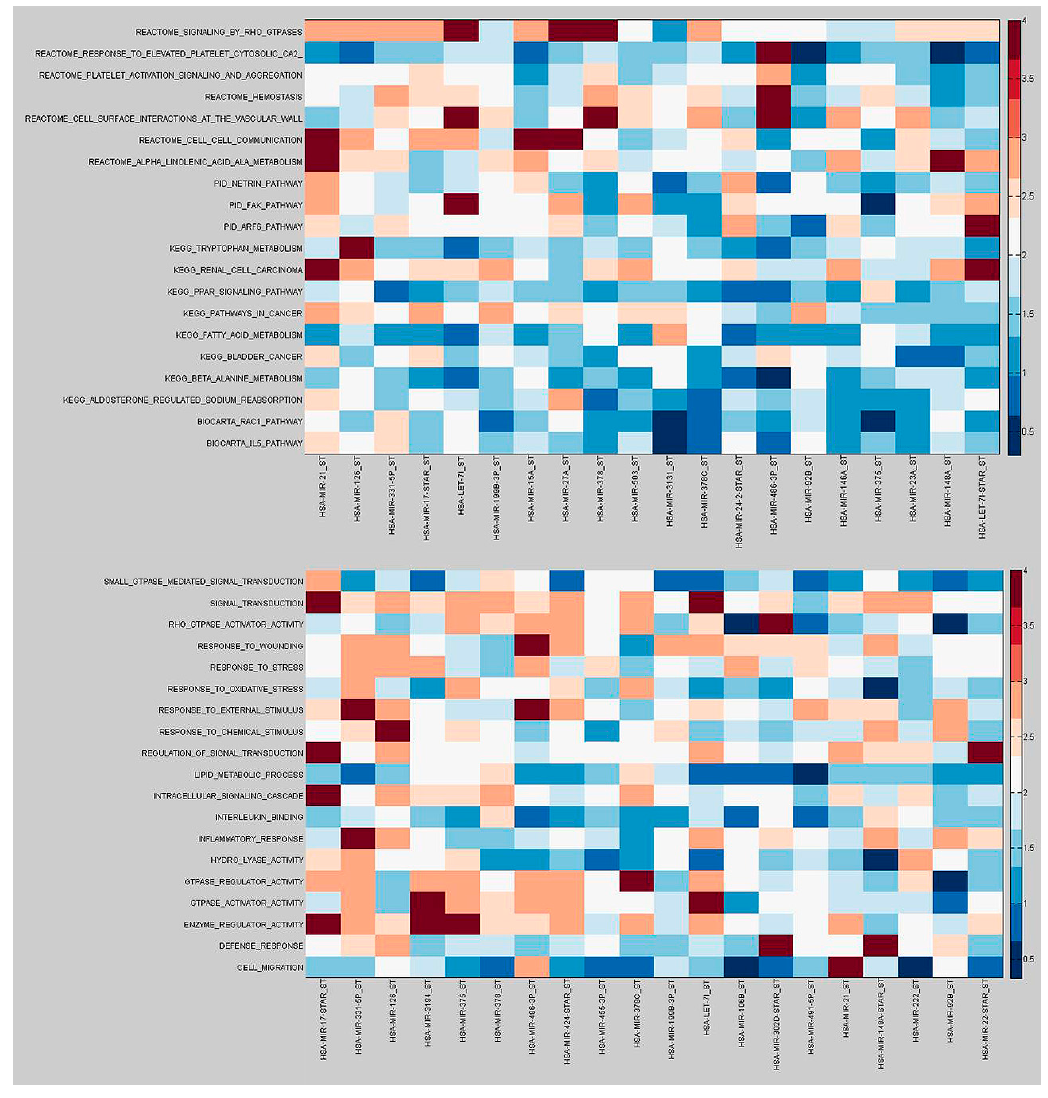
Figure 6. Heatmap of the –log 10 ( p -values) for differential co-expression between the top-ranked differentially co-expressed (DC) pathways, differentially expressed (DE) pathways, and specific miRNAs (top: Canonical pathways, bottom: GO terms).